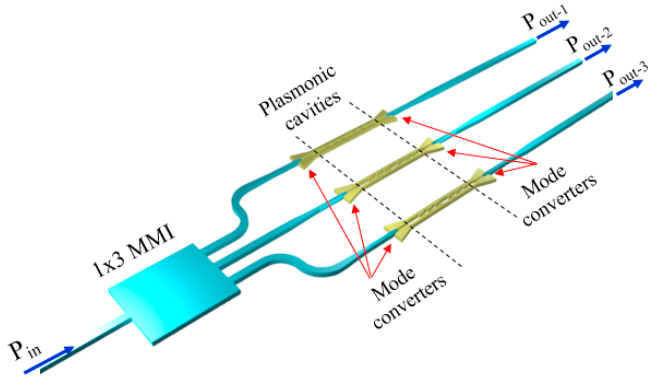
Figure 1. Biosensing platform for the detection and monitoring of several protein biomarkers. Optical fibers that should be coupled to the input and output waveguides are not shown. Figure not to scale.